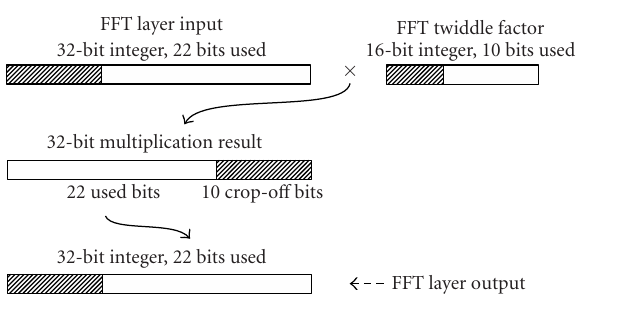
Figure 4: Multiplication of a 22-bit integer, followed by a bit shift in a layer of the proposed FFT.